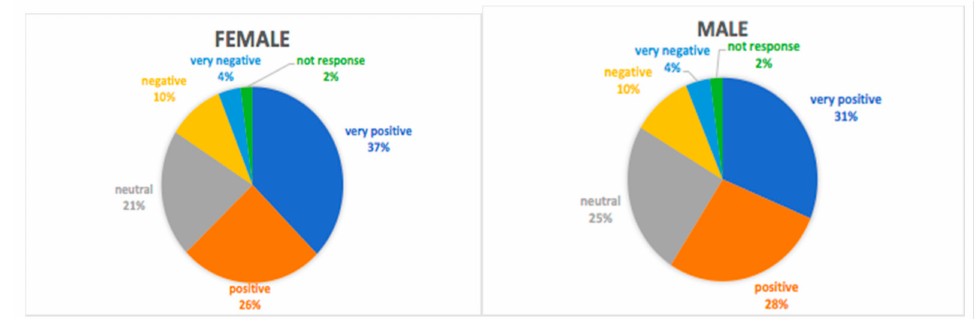
Figure 8. Results of the relevance dimension by